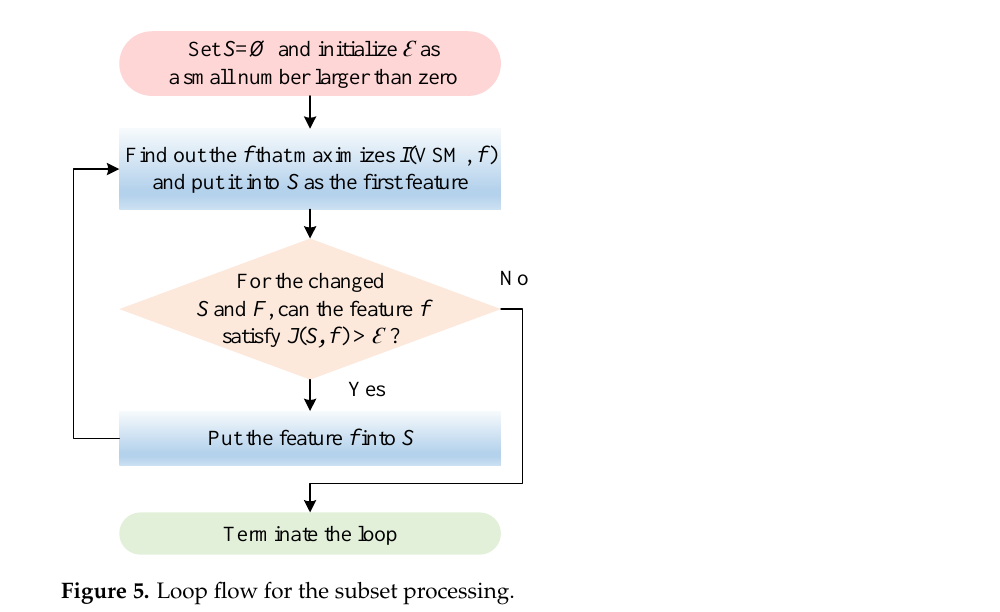
Figure 4. Flow chart of the division strategy.